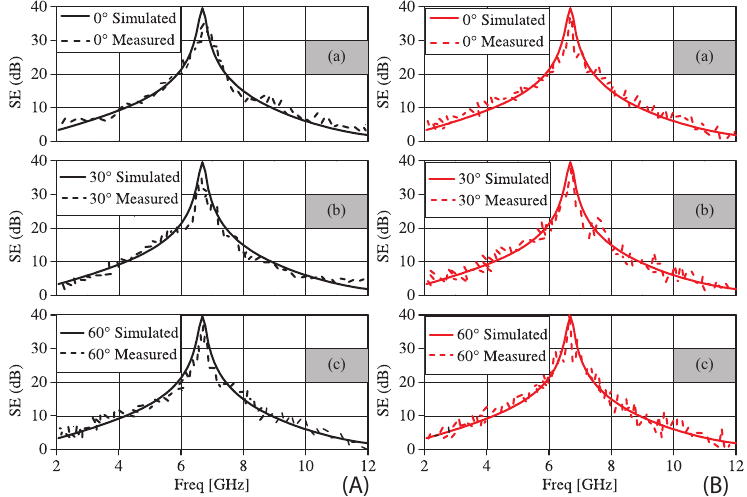
Figure 12. ( A ) Performance comparison of the FSS with metallic strips for the TE/TM polarization at ( a ) 0 ◦ , ( b ) 30 ◦ , and ( c ) 60 ◦ . ( B ) Performance comparison for 45 ◦ polarization at ( a ) 0 ◦ , ( b ) 30 ◦ , and ( c ) 60 ◦